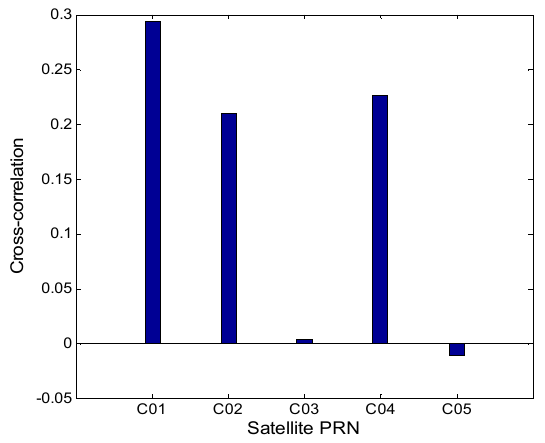
Figure 7. The Spearman cross-correlations between the multipath delay in CUTO and that in JFNG.